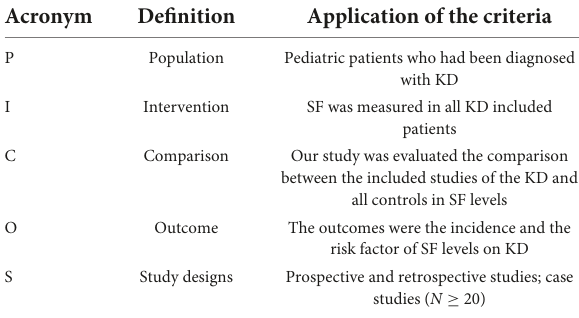
TABLE 1 Participants, Intervention, Comparator, Outcomes, and Study design (PICOS) criteria for inclusion in the systematic review and